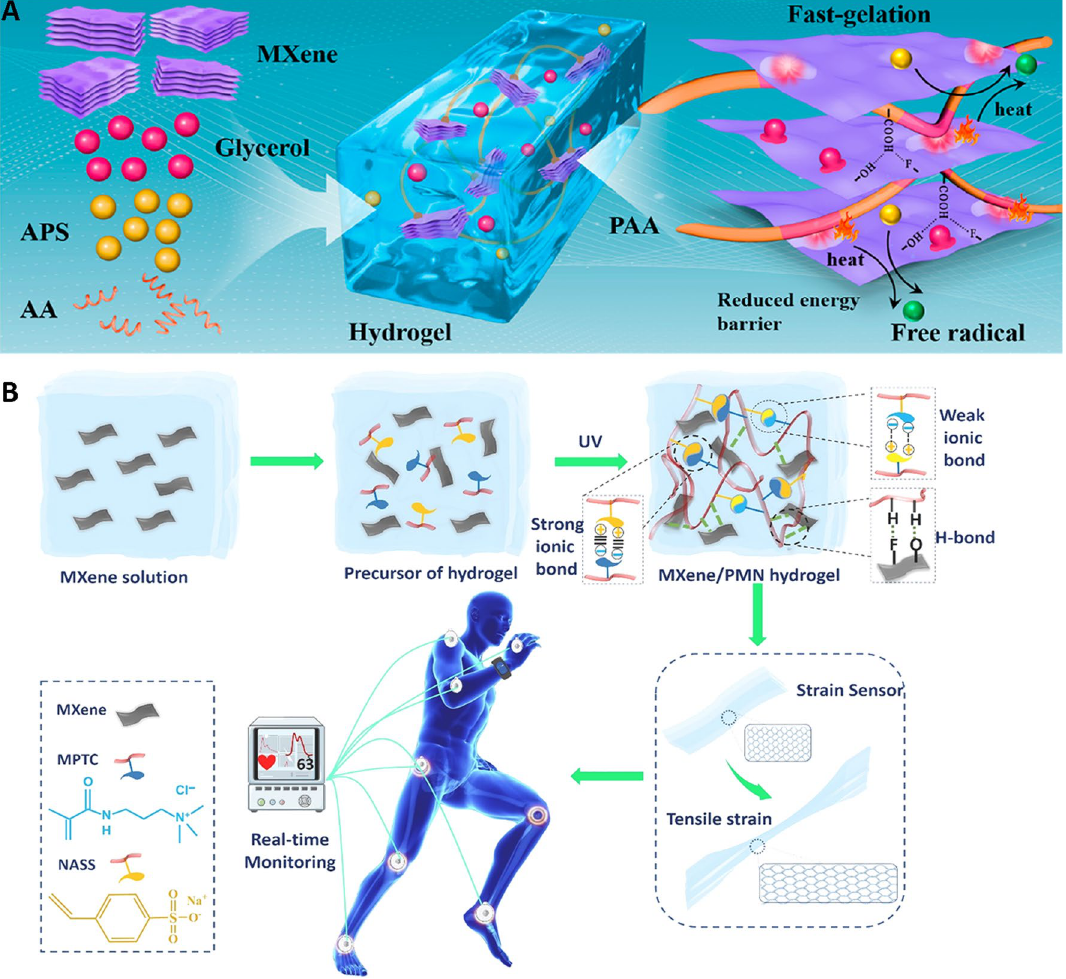
Fig. 2 A The preparative process of PAA-MXene hydrogels, with related gelation mechanism. APS: ammonium persulfate; AA: acrylic acid. Reproduced from Ref. [36] with permission. Copyright, 2021 American Chemical Society. B The preparative process of